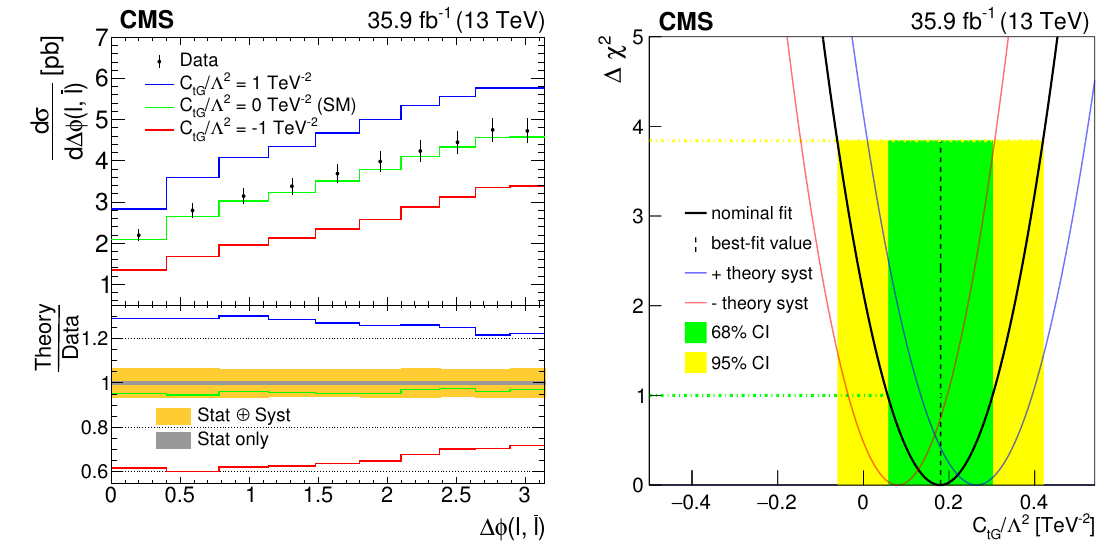
Figure 54 . In the left plot, the di(cid:11)erential tt cross sections as a function of (cid:1) (cid:30) ( ‘; (cid:22) ‘ ) at the particle level in a (cid:12)ducial phase space described in the text are shown. The points correspond to data and vertical bars on the points give the total uncertainty. The solid lines show the NLO predictions from the mg 5 a mc@nlo generator interfaced with pythia for C tG = (cid:3) 2 values of 1.0, 0.0, and (cid:0) 1 : 0 TeV (cid:0) 2 . The lower plot displays the ratio of the theoretical predictions to the data. In the right plot, (cid:1) (cid:31) 2 values from the (cid:12)t to the data in the left plot are shown as a function of C tG = (cid:3) 2 . The dark curve gives the result of the nominal (cid:12)t, with the vertical dashed line giving the best-(cid:12)t value. The two horizontal dashed lines indicate the (cid:1) (cid:31) 2 values for the 68 and 95% CIs. The dark and light bands correspond to those 68 and 95% CIs, respectively. The other curves show the (cid:1) (cid:31) 2 values for (cid:12)ts that give the maximally positive and negative changes in the best-(cid:12)t value when the theoretical predictions are allowed to vary within their systematic